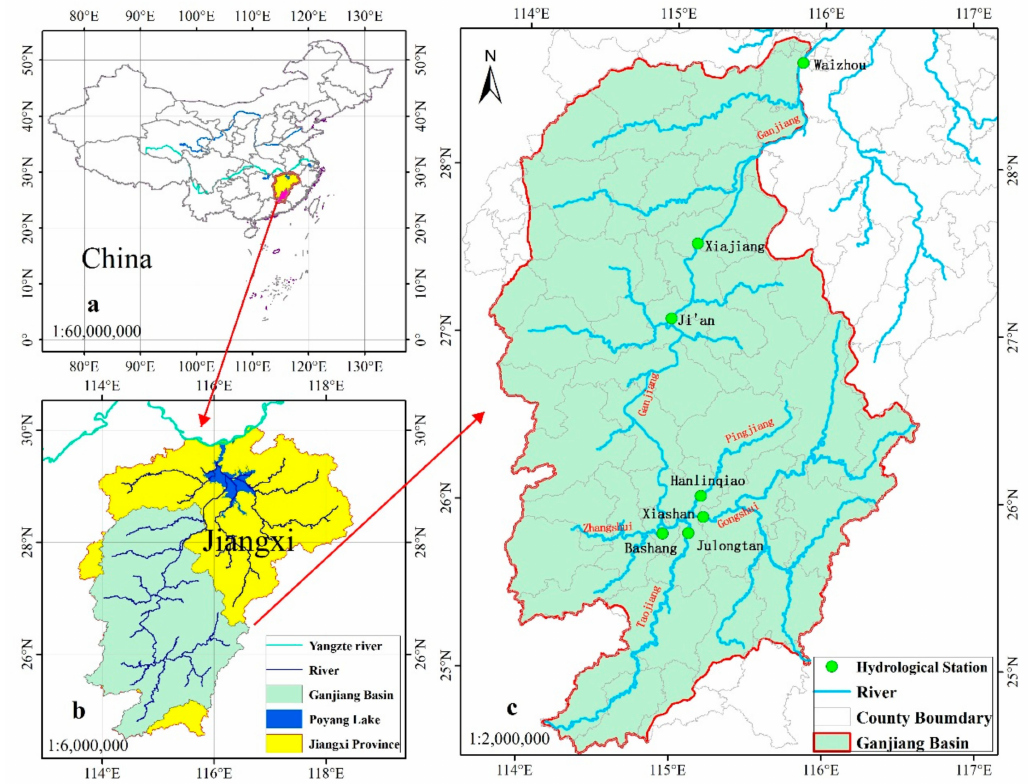
Figure 1. Location of study region and main hydrological stations on the Ganjiang